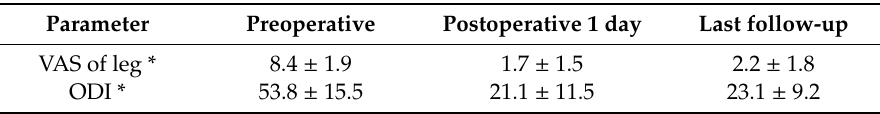
Table 2. Clinical